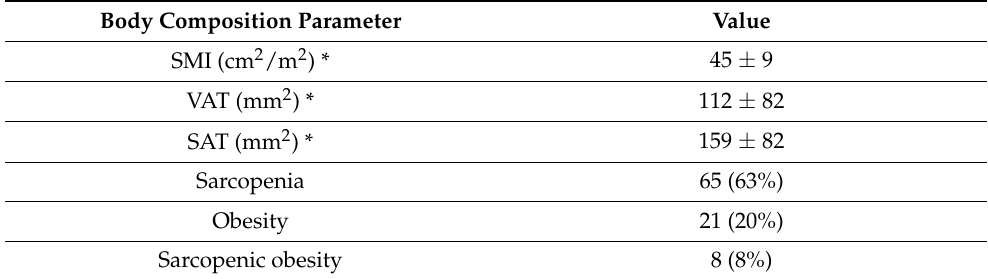
Table 2. AI-derived body composition parameters at the third lumbar vertebra level in patients with pancreatic adenocarcinoma. SMI = skeletal muscle index. VAT = visceral adipose tissue. SAT = subcutaneous adipose tissue. * Median ± standard